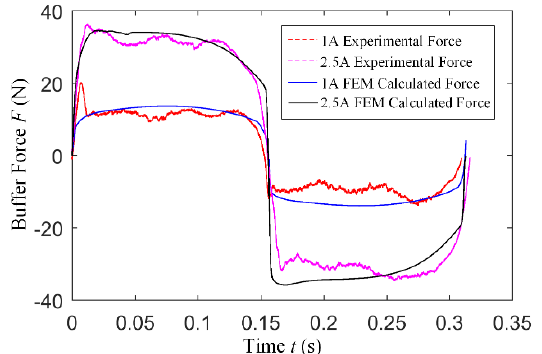
Energies 2019 , 12 , x FOR PEER REVIEW ff er force curve at 3 Hz frequency. Figure 18. Buffer force curve at 3 Hz frequency. Figure 18. Bu Figure 18. Buffer force curve at 3 Hz frequency.